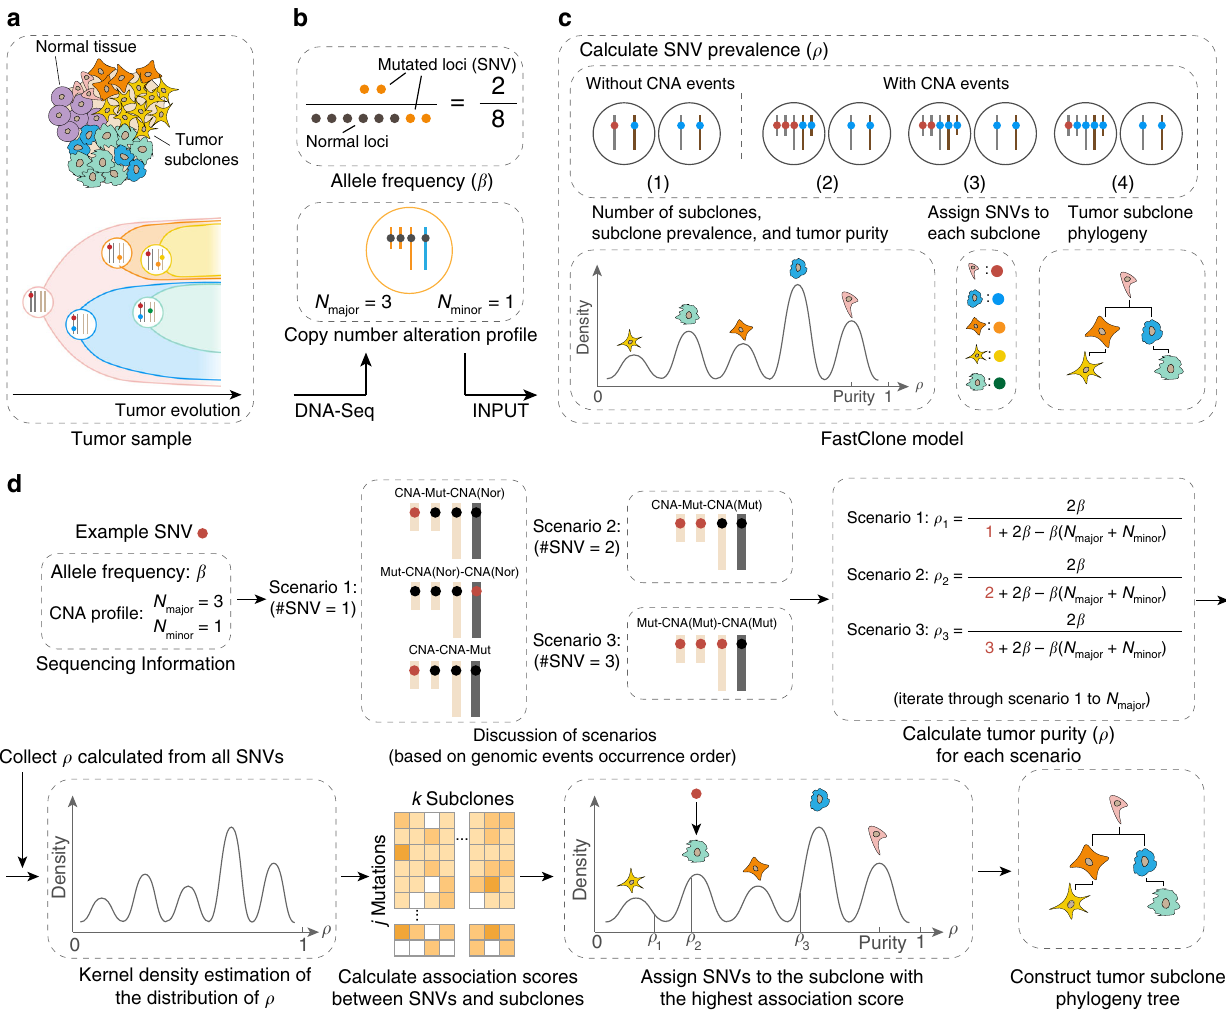
Assign SNVs to the subclone with scoreCalculate association scores the highest association between SNVs and subclones Fig. 1 Overview of the FastClone algorithm. a The tumor sample is heterogeneous, composed of both normal cells and tumor subclones (top panel). The tumor dynamically evolves throughout the disease course, generating subclones with different genotypes (bottom panel). The dots in different colors represent different SNVs. b DNA-sequencing of the bulk tumor provides information about (1) allele frequency of each SNV ( β ), that is, the observed allele occurrence among all cells (top panel); (2) a CNA pro fi le in the form of N major and N minor (bottom panel). Each of the yellow dots represents a copy of the allele with a certain SNV. c FastClone model. First, we calculated the proportion of cells that carry each SNV ( ρ i for SNV i ). This calculation is discussed in two situations: with and without CNA events. Multiple possibilities are further discussed (see Fig. 2). Blue spheres represent normal loci, and red spheres represent mutated loci that contain SNVs. Then, subclone numbers, subclone proportions, and tumor purity are determined from the distribution of ρ . After that, SNVs are assigned to subclones. Finally, the putative evolutionary relationship of the subclones is established. d The work fl ow of FastClone algorithm. The work fl ow starts with sequencing information as input, which includes allele frequency ( β ) and CNA pro fi le ( N major and N minor ). Since we do not know the order of occurrence of genomic events, all possible scenarios are discussed, and ρ value for each scenario is calculated separately. The number of possible scenarios equals the value of N major . Then, KDE is used to determine the distribution of ρ . Each peak in the ρ distribution indicates a subclone. After that, association scores between each SNV – subclone pair are calculated. Then, the SNV is assigned to the subclone with the highest association score. If there are several ρ values associated with one SNV, then the ρ that provides the highest association score is used to assign the SNV to the subclone (in this case, ρ 2 that assigns this SNV to the green subclone is considered the correct solution). Finally, the most likely phylogeny tree of the subclones is